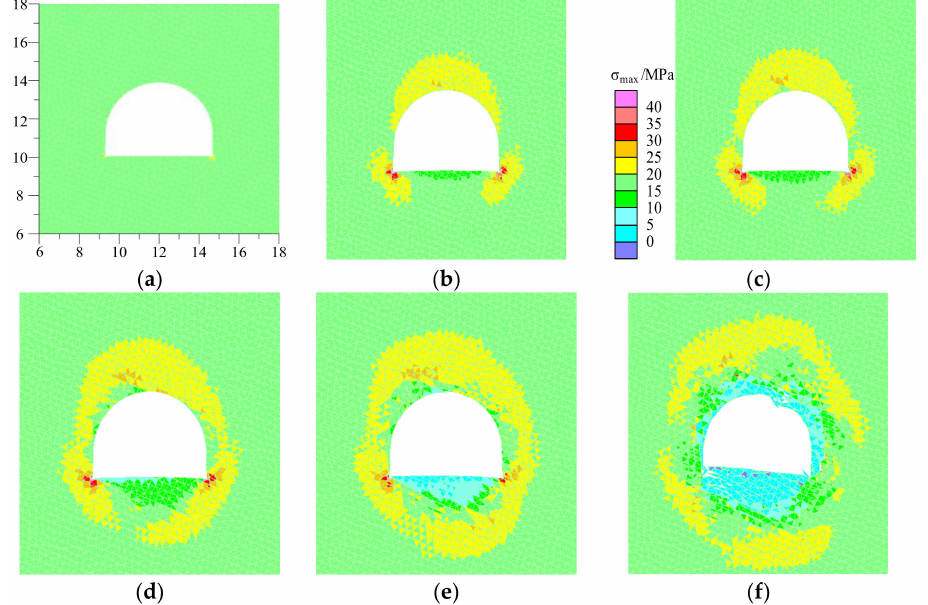
Figure 16. Maximum principal stress evolution characters in the roadway surrounding rock during the excavation unloading process: ( a ) unloading stage 1; ( b ) unloading stage 6; ( c ) unloading stage 7; ( d ) unloading stage 8; ( e ) unloading stage; ( f ) unloading stage